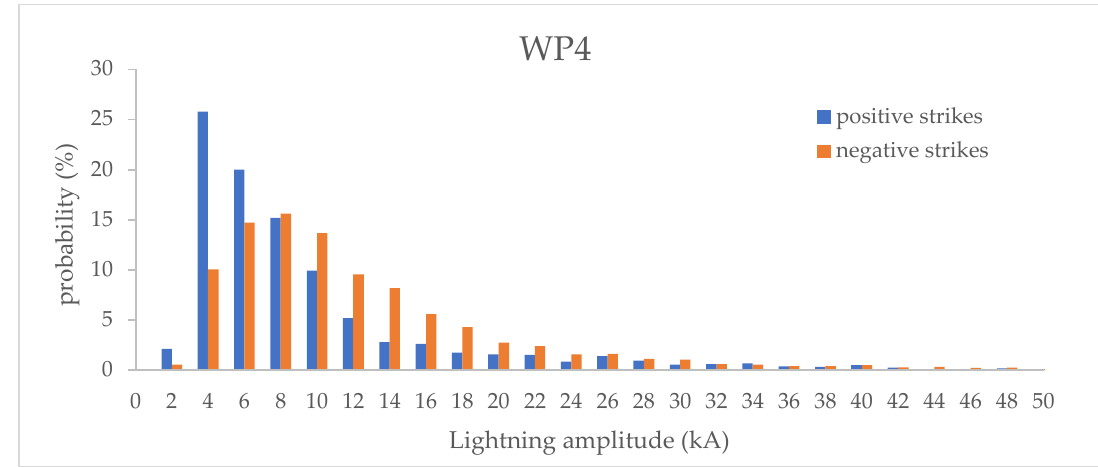
Figure A3. Lightning current amplitude probability distributions for positive and negative strikes extracted from the rec- orded incidents throughout the period 2011–2020 for WP3.